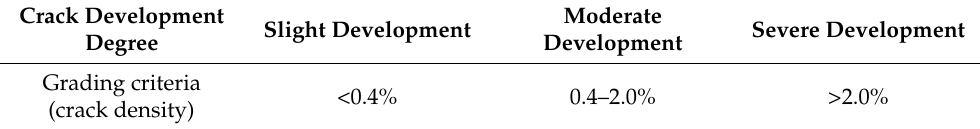
Figure 7. The results for soil moisture evaporation in 24 h from loess and sandy soils at the different crack densities. Table 5. The results for the construction of grading criteria for the degree of crack development.